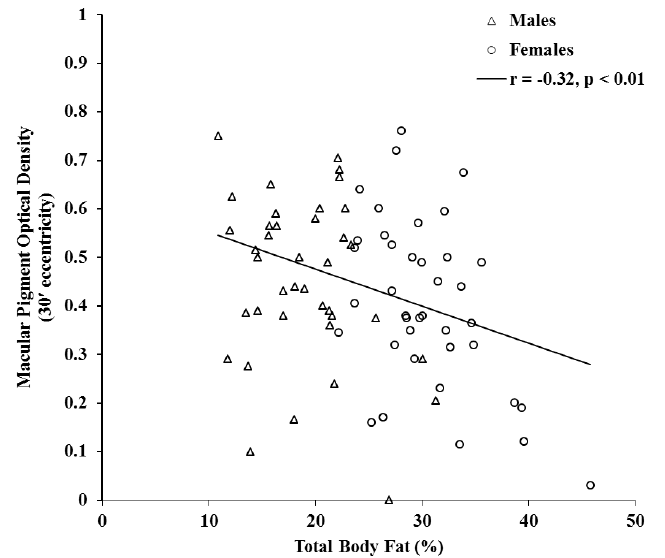
Figure 1. The relationship between MPOD at 30  eccentricity and total body fat percentage.